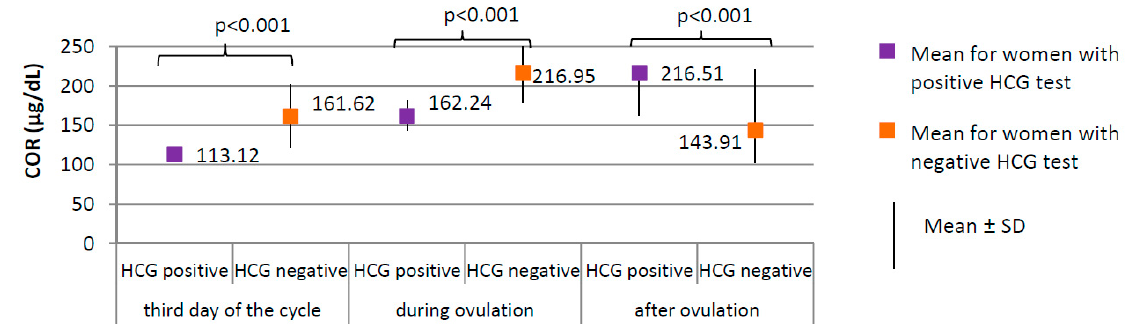
Figure 4. Comparison of COR (cortisol) between women with positive HCG test ( N = 17) and women with negative HCG test ( N = 188).